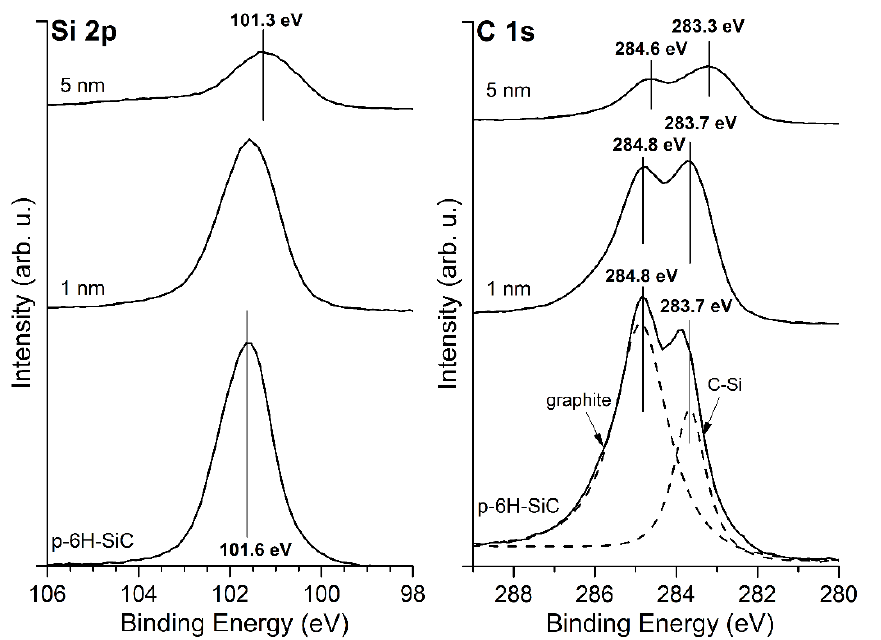
Figure 6. XPS spectra of Si 2p and C 1s core level lines for the bare graphite/SiC(0001) system and covered with MgO layers of an average thickness of 1 and 5 nm. For the bare graphite/SiC(0001), two components of C 1s peak, i.e., the C – C and C – Si bonding, are clearly visible. The C 1s peak contains two components, first at a BE of 283.7 eV attributed to C – Si bonds, and second at a BE of 284.8 eV to C – C bonds, which come from the graphite layer. The position of the C 1s for the graphite phase is in line with [8,9]. The C 1s shifts towards a lower BE to the position of 283.3 eV and 284.6. After the deposition of MgO layers, the Mg 2p peak and O 1s are located at 51.0 eV and 531.6 eV, respectively. The positions are the same as for the layers deposited on the SiC(0001) sample presented in Figure 3. gap of the MgO layers is 6.7 eV.